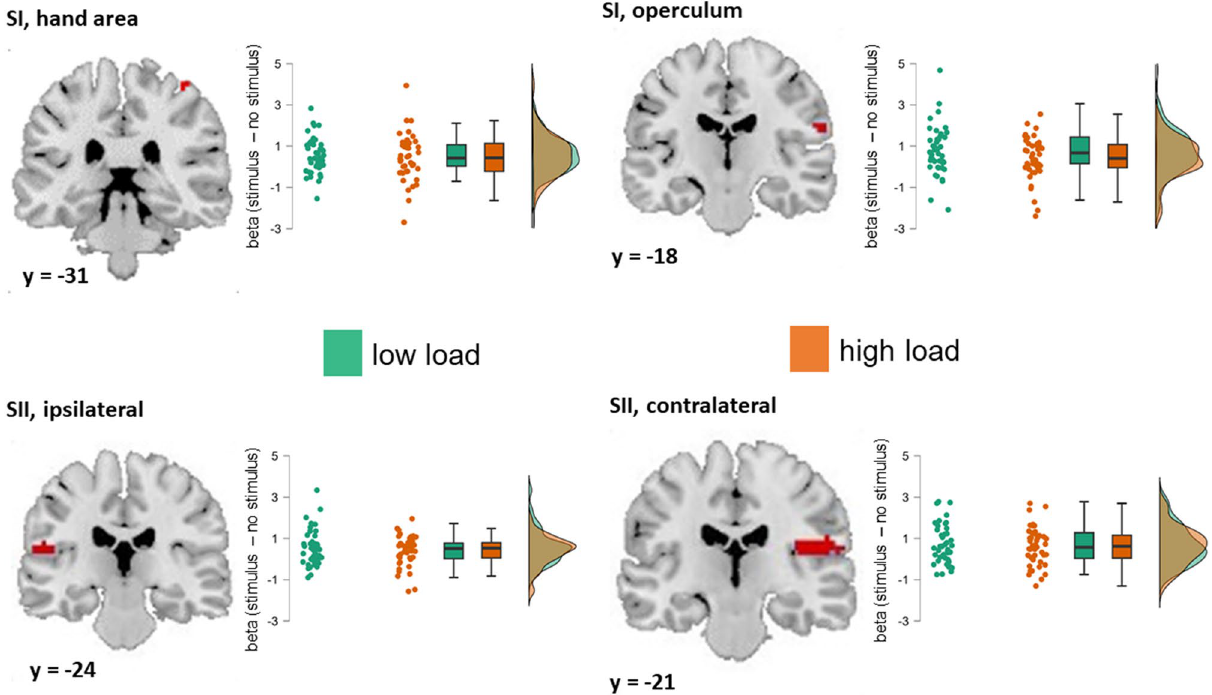
Figure 4. Clusters of increased activity in the stimulus compared to the no stimulus condition in the somatosensory areas in the primary and secondary somatosensory cortices (displayed in Fig. 2) for N = 44 participants. In the primary somatosensory cortex, three clusters with increased activity can be found: Two corresponding to the hand area of the left wrist, where the somatosensory stimuli were applied and one in the right parietal operculum in the neighbourhood of the secondary somatosensory cortex (cluster 1: peak t -value = 3.59, cluster 2: peak t -value = 4.64, both p < 0.05). In the secondary somatosensory cortex, one cluster can be found on each side (ipsilateral: peak t -value = 4.96, contralateral: peak t-value = 6.03, both p < 0.05). Displays of the clusters are accompanied by raincloud plots of the individual data points in each condition, comprising a jittered scatter plot of the cluster average of the betas per subject, a box-and-whisker plot, and a violin plot of the same data.